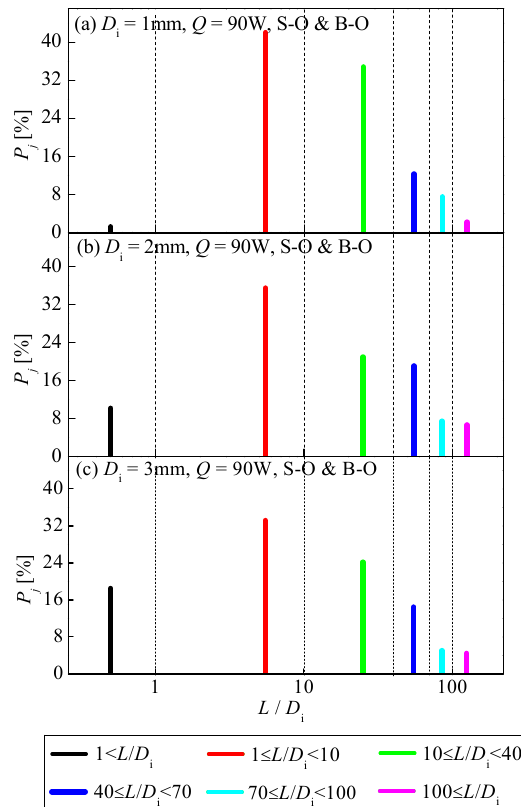
Figure 8. Distribution of bubbles/slugs length at the condenser in the OHPs with different inner diameters under quasi-steady S-O and B-O fluid motion: ( a ) D i = 1mm under Q = 90W; ( b ) D i = 2mm under Q = 90W; and ( c ) D i = 3mm under Q = 90W.